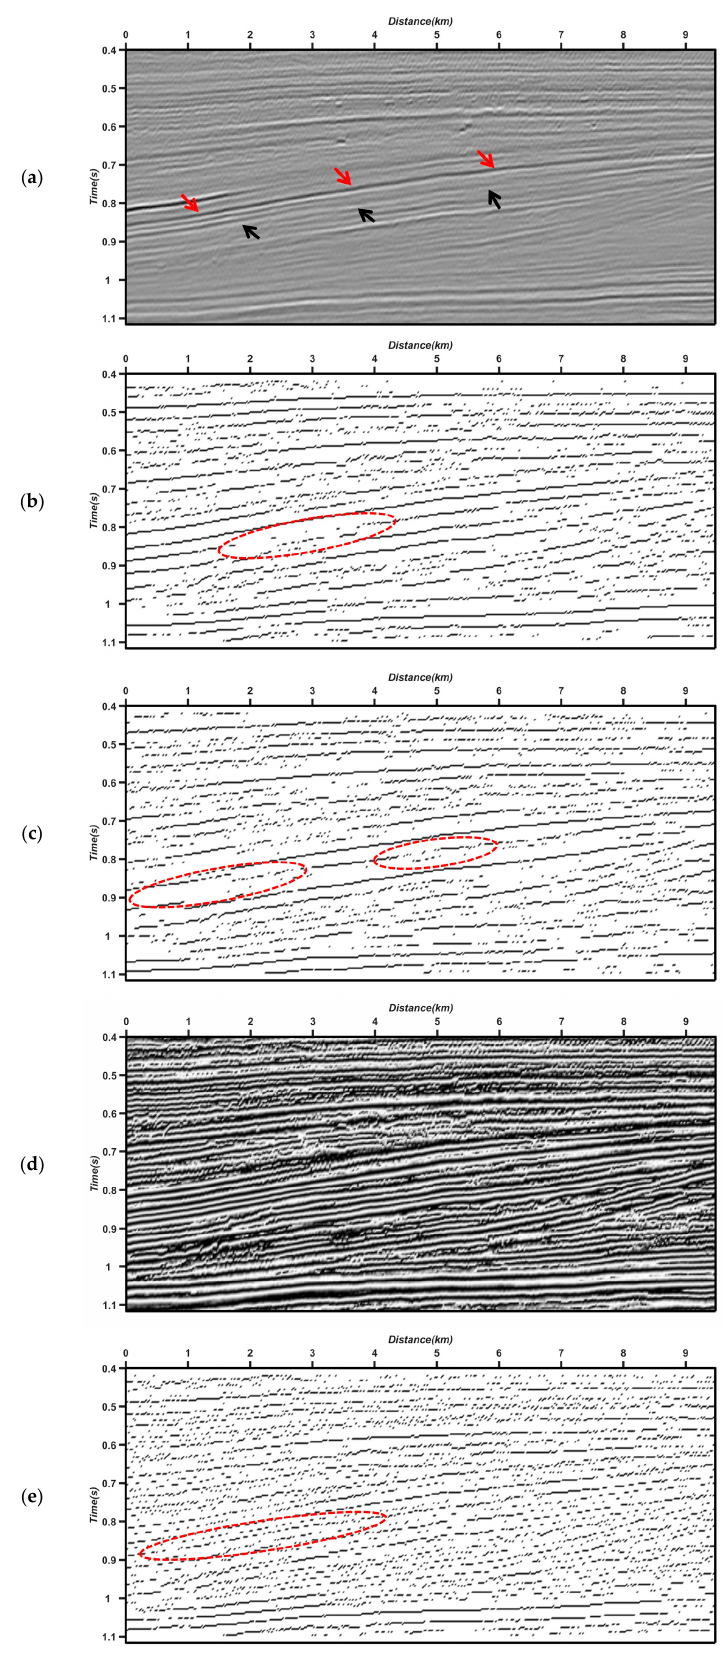
Figure 5. ( a ) Local migration imaging results, ( b ) envelope, ( c ) instantaneous phase, ( d ) dip, and ( e ) tracked horizon (the blue curve is the result via conventional waveform similar method, and the red curve is the result via the proposed method) overlaid with seismic image. 5.2. The North Sea F3 Field Data The second example illustrates the application of the proposed method to a real 3-D seismic survey F3 acquired over the North Sea. The extracted slice is shown in Figure 6a, and the instantaneous phase attribute is shown in Figure 6d. We observe that there is an obvious reflection horizon shown as the red arrow, and there is also a horizon with weak amplitude and less continuity, within the depth range of 0.8 km~0.9 km and the horizon position 0~1 km. Figure 6b,e show the troughs of the seismic data and the instantaneous phase attribute. Figure 6c,f show the peaks of the seismic data and the instantaneous phase attribute. Whatever a trough or a peak is shown the seismic data and the instantaneous phase attribute, the horizon shows poor continuity, which is marked by circles shown in Figure 6b,c,e,f. We cannot pick the correct reflection horizon according to any of these attributes. Figure 6g,h show the tracked horizon (red curve) using our proposed method on the image and waveform of seismic data, respectively. The blue cross symbols in Figure 6g,h are the seed points obtained via manual interpretation. Note that the waveform is similar and easy to track within the left portion and the right portion of the seismic slice. The waveform changes rapidly within the middle portion of the seismic slice, which makes it difficult to obtain the correct horizon position via the conventional method. How- ever, the tracked horizon using the proposed method exactly follows the seismic reflection event.